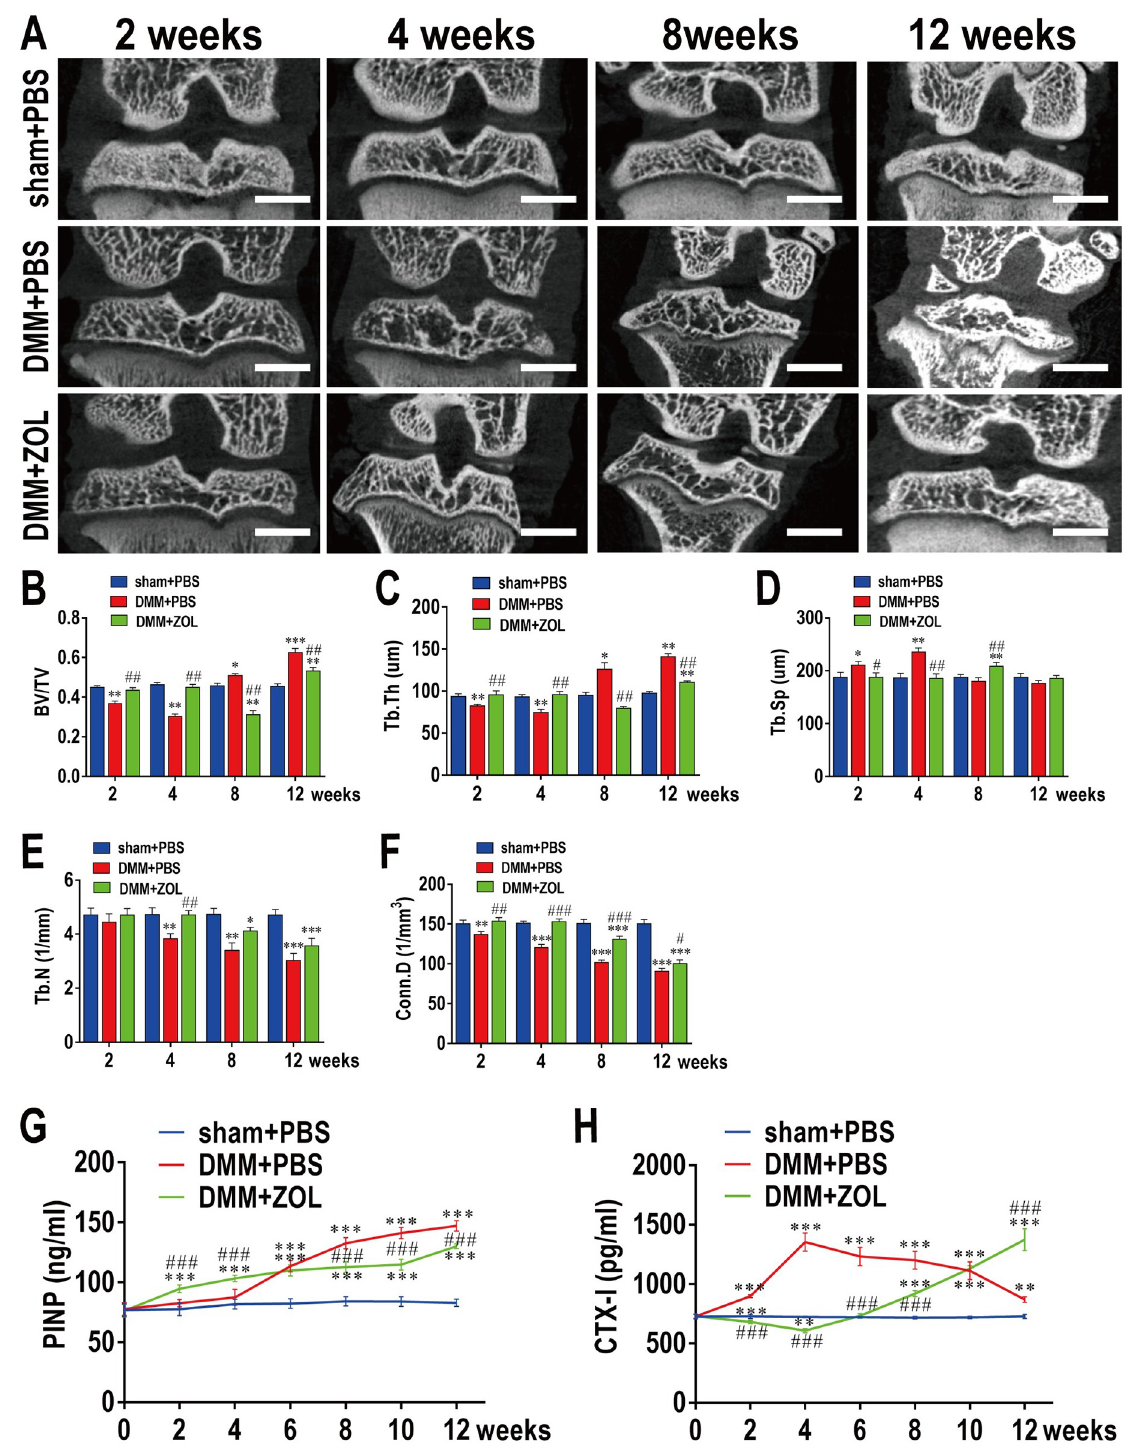
Fig 2. DMM-induced abnormal subchondral bone remodeling is inhibited by ZOL. (A) Reconstructed coronal μ CT images of tibial subchondral bone at various time-points after OA induction. Scale bar, 2,000 μ m. (B, C, D, E, and F) Quantitative μ CT analyses of microarchitecture in tibial subchondral bone: (B) BV/TV (%), (C) Tb.Th, (D) Tb.Sp, (E) Tb.N and (F) Conn.D (n = 6 per group/time point). Quantitative analysis of (G) PINP and (H) CTX-I at various time-points (n = 6 per group/time point). � P < 0.05, �� P < 0.01, and ��� P < 0.001, compared with sham+PBS group; # P < 0.05, ## P < 0.01, and ### P < 0.001, compared with DMM+PBS group.